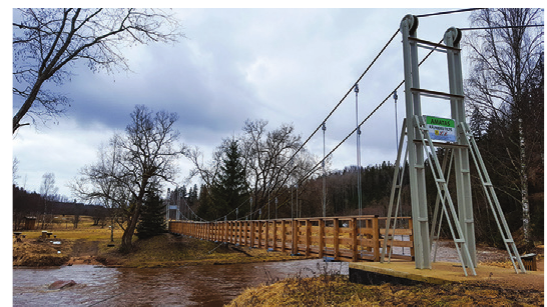
Fig. 1. Pedestrian suspension bridge over Amata River